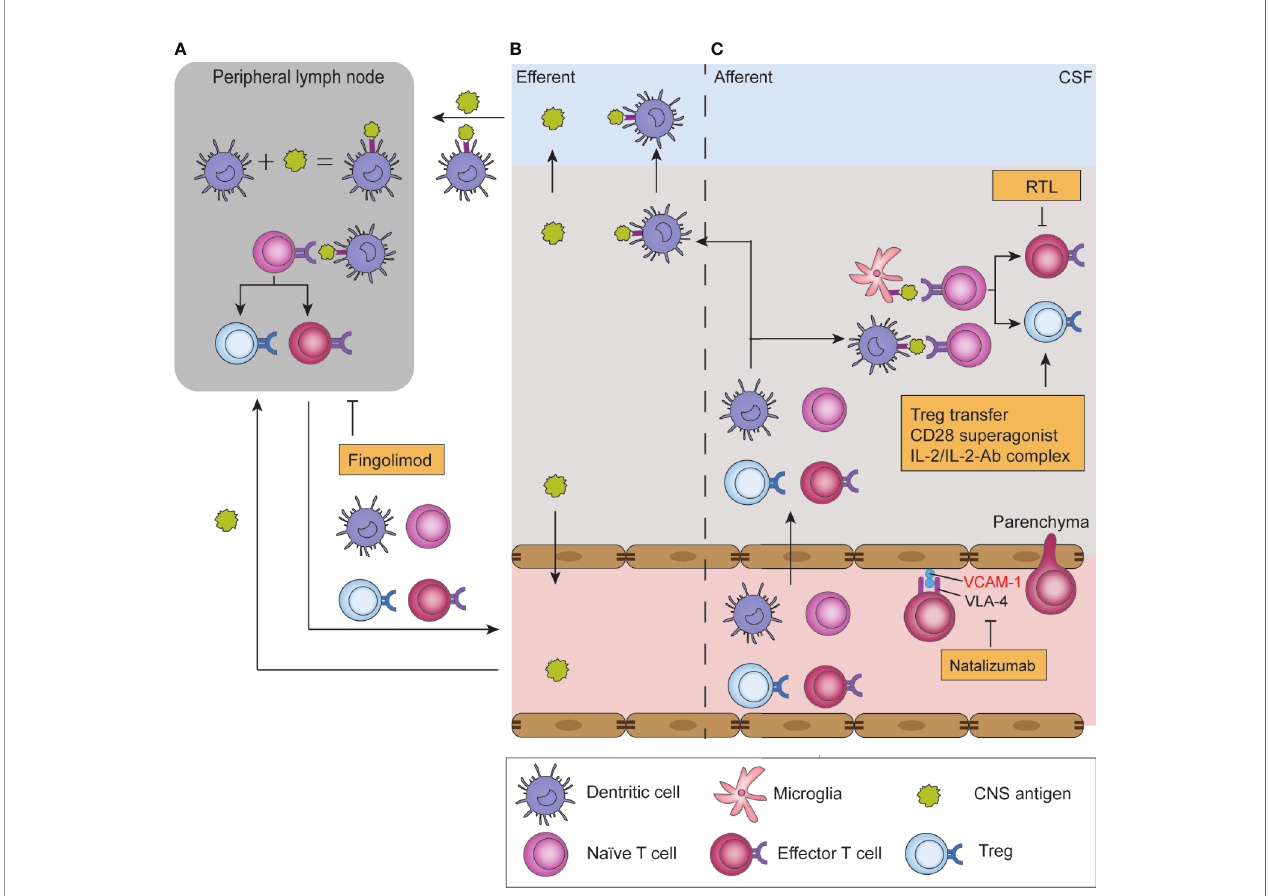
FIGURE 2 | Antigen presentation in ischemic stroke and T cell-related therapeutic targets. After ischemic stroke, soluble antigens are leaked to the blood or CSF and reach draining lymph nodes; alternatively, they are presented by in fi ltrated dendritic cells and migrate with these cells (B) . In peripheral lymph nodes, antigens are presented by antigen-presenting cells and are recognized by naïve T cells, which triggers their proliferation and production of effector T cells and Tregs, a process termed “ T cell priming ” (A) . Moreover, T cell priming also occurs in the parenchyma, where in fi ltrated naïve T cells encounter antigens presented by microglia and dendritic cells. Subsequently, primed T cells migrate to the parenchyma where they reencounter their speci fi c antigen and exert their function in an antigen- dependent way (C) . T-cell-targeted therapies include natalizumab, which blocks T cell adhesion to endothelial cells by blocking the adhesion molecule VLA-4. Fingolimod blocks T cell egression from lymph nodes, and therefore induces lymphopenia. Recombinant T cell ligands (RTL) block effector T cell functions, while Treg-targeted therapies boost Treg